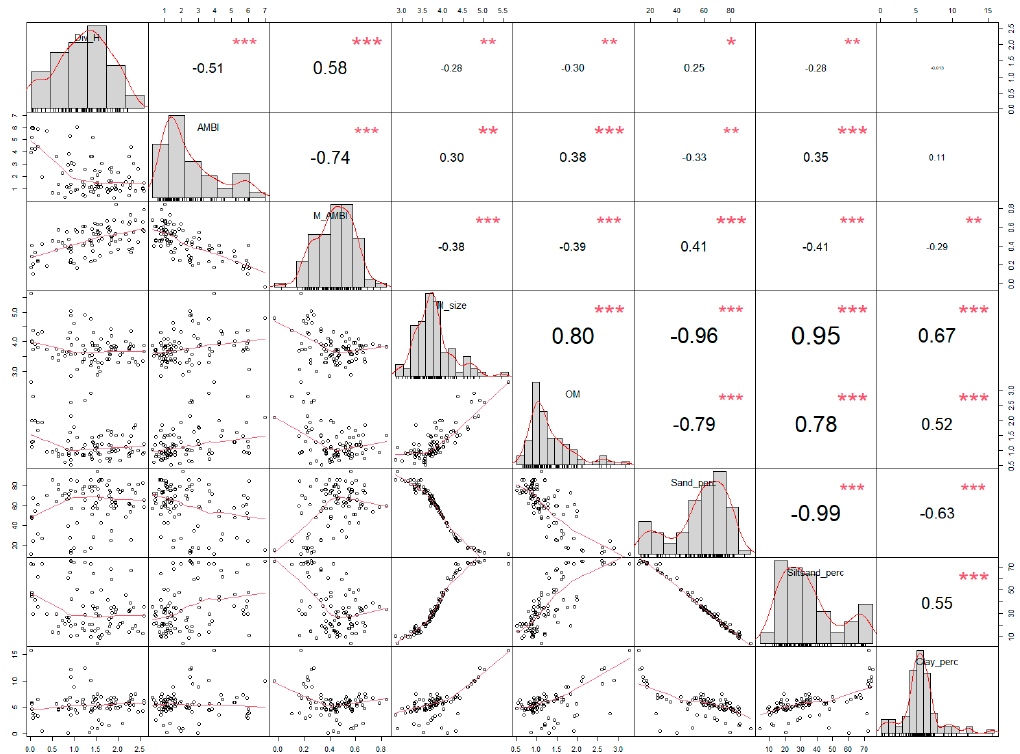
Figure 5. Correlation analysis between H ′ , AMBI, and M-AMBI with environmental parameters in the intertidal flats of the Liaohe Estuary. Note: * p < 0.05, ** p < 0.01, *** p < 0.001; Div_ H ′ , AMBI, and M-AMBI indicate the Shannon–Wiener diversity index, AZTI’s Marine Biotic Index and Multivariate-AMBI Index, respectively; OM, M_size, Clay_perc, Sand_perc, and Siltsand_perc indicates the organic matter content, median grain size, clay content, sand content and siltsand content of sediment, respectively.